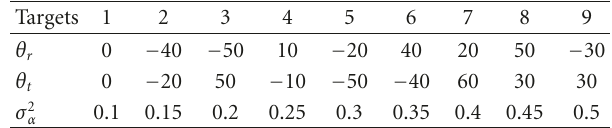
Table 2: Locations of the six targets.